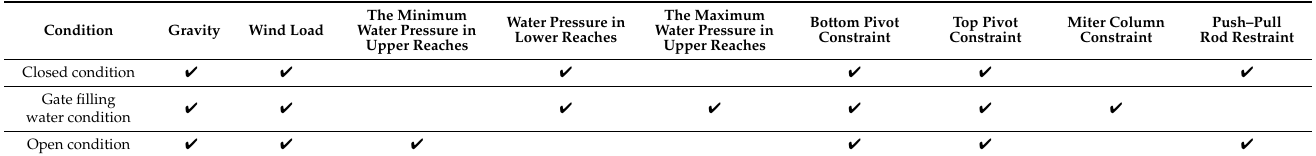
Table 1. Stress load and constraint of the gate under different states.